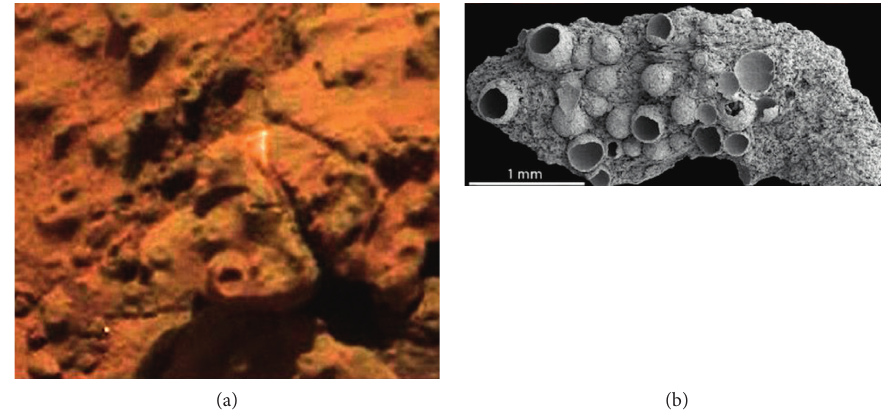
Figure 5: Gale crater/sol 232. (a) Specimens similar to open cone and gas-vent apertures formed via the release of oxygen secondary to photosynthesis. Photosynthesizing organisms respire oxygen and release gas bubbles into the surrounding matrix, thereby, fashioning these vents. Surrounding green substance may be algae/cyanobacteria ([38]; reproduced with permission). (b) Open globular structures,